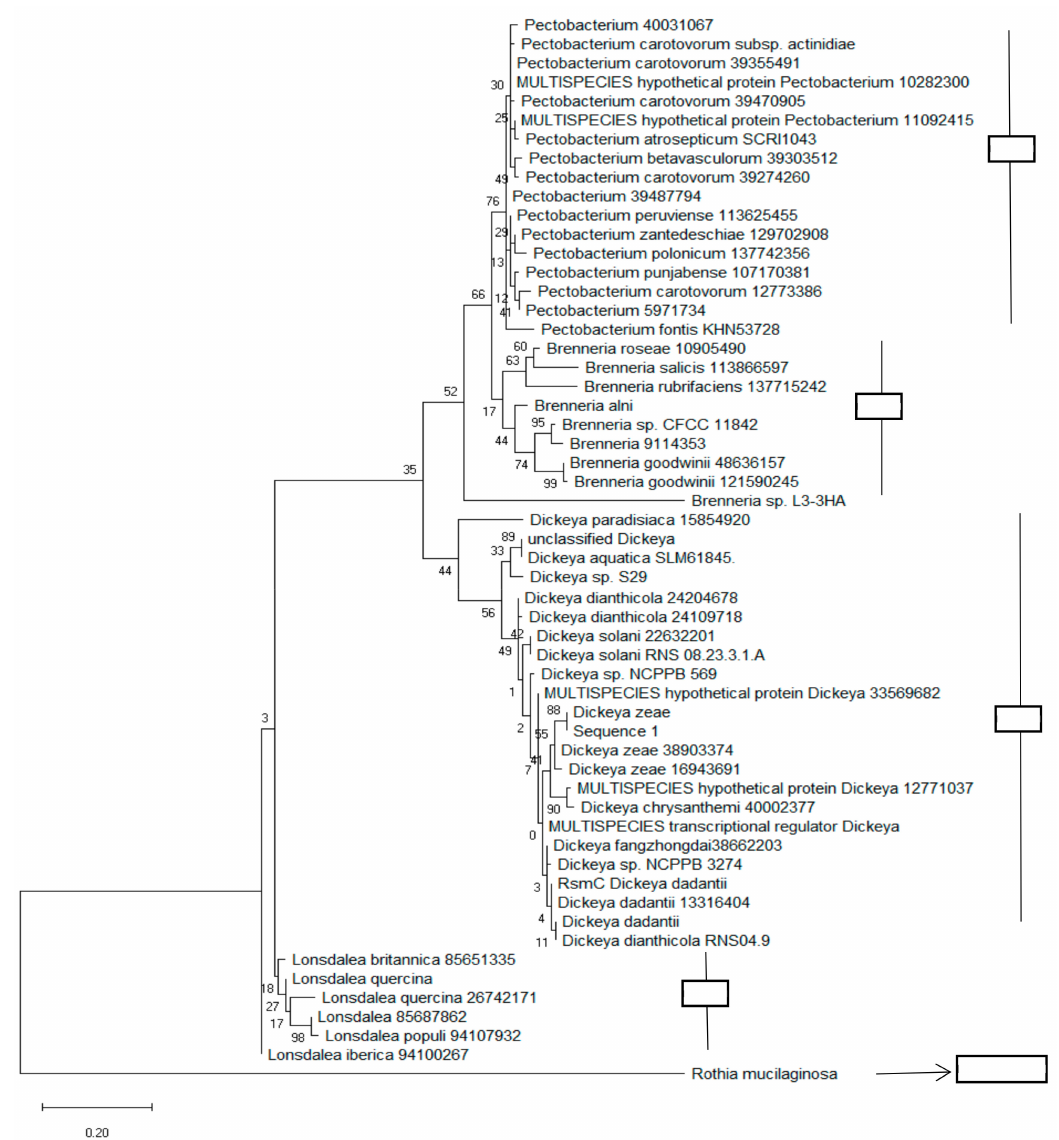
Figure 4. Phylogenetic tree constructed based on the rsmC sequence. The branching pattern was constructed using the neighbor-joining method [54]. The numbers which are present at the nodes representing the levels of bootstrap support based on a neighbor-joining study of a set of 500 resampled data. The evolutionary distances were calculated by the maximum composite likelihood method